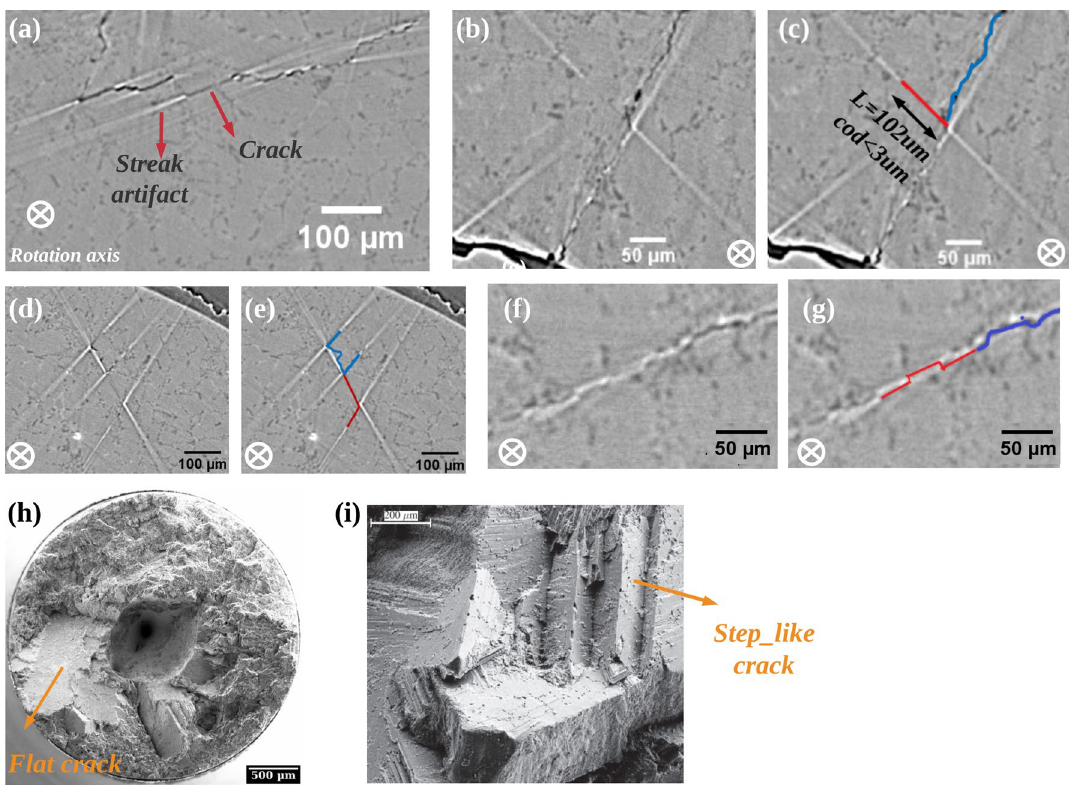
Figure 12. Analysis of cracks and artifacts in horizontal slices of experimental scans: the experimental SRCT images of a cracked AlSi7 specimen which have been obtained at SOLEIL PSICHE beamline ( a – e ) and SLS TOMCAT beamline ( f , g ) show the same streak artifacts as in the simulated image. The scans conditions of ( a – e ) are completely identical as in Fig. 2; the scans conditions of ( f , g ): energy 30 keV, distance between the sample and the detector 15 cm and voxel size 1.6 µ m. All slices are horizontal slices (perpendicular to the rotation axis). ( a ) The same 2D experimental horizontal slice as in Fig. 1b, flat crack with dark and white streak artifact at the ends of the crack can be observed. Tomography images of various parts of the crack are shown in ( b , d , f ). On these images a red line has been added to indicate (based on the simulation results) that a crack is present in the sample ( c ), ( e , g ) and blue lines have been added to the crack segments which can be unambiguously determined (black voxels). ( h , i ) SEM observation of the fracture surfaces of the fatigue tested specimen at two different